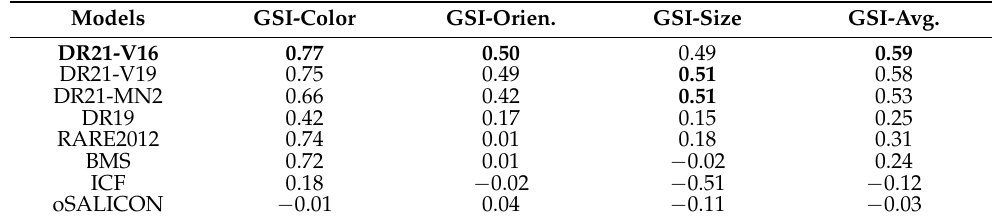
Figure 11. Number of fixations (horizontal axis) vs. % of targets detected (vertical axis). It is chosen on 15, 25, 50, and 100 fixations. Table 12. Comparing results on the P 3 dataset. Global Saliency Index score on color, orientation, and size features, and average score from these three